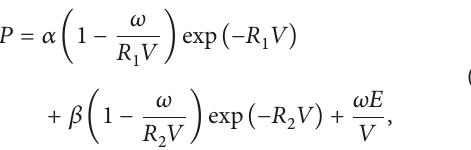
points. Thus, the explosion waves were strengthened on the midcourt lines. Then, the line scars were formed. The line approximately paralleled the axes of the